Question: According to this chart, does the measure grow or shrink?
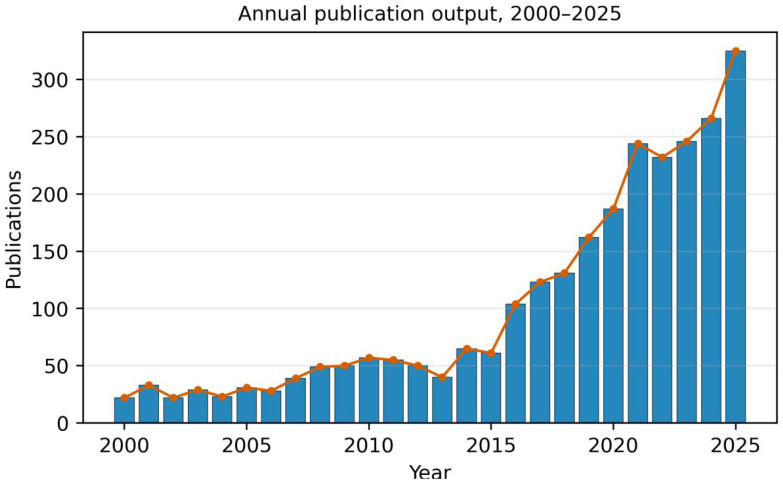
Answer: increasing